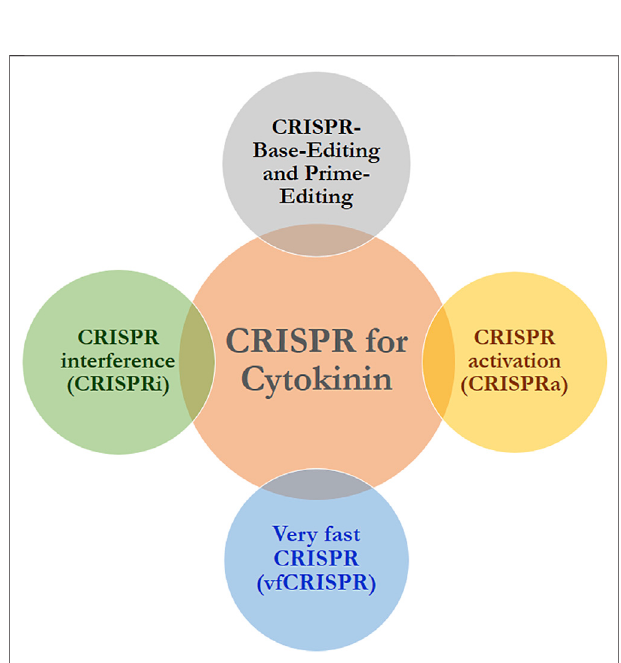
FIGURE 2 | Schematic representation for the cytokinin biosynthesis and degradation pathways.